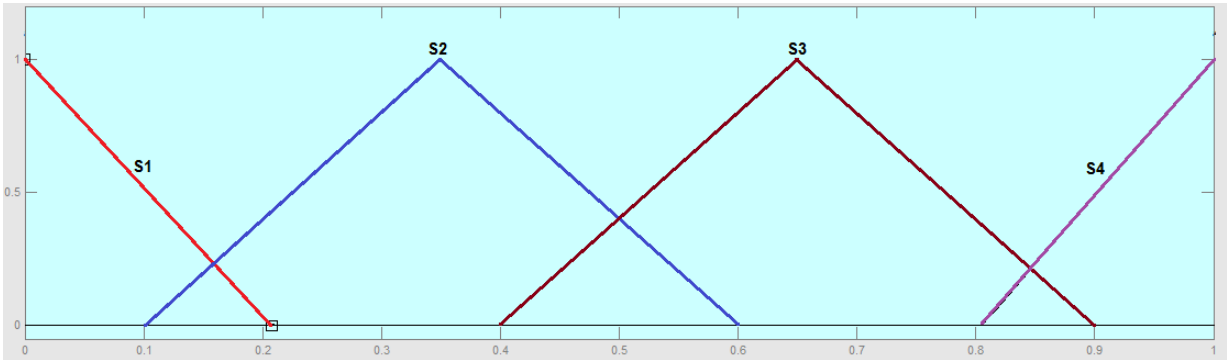
Figure 8. Membership function plot of output variable.